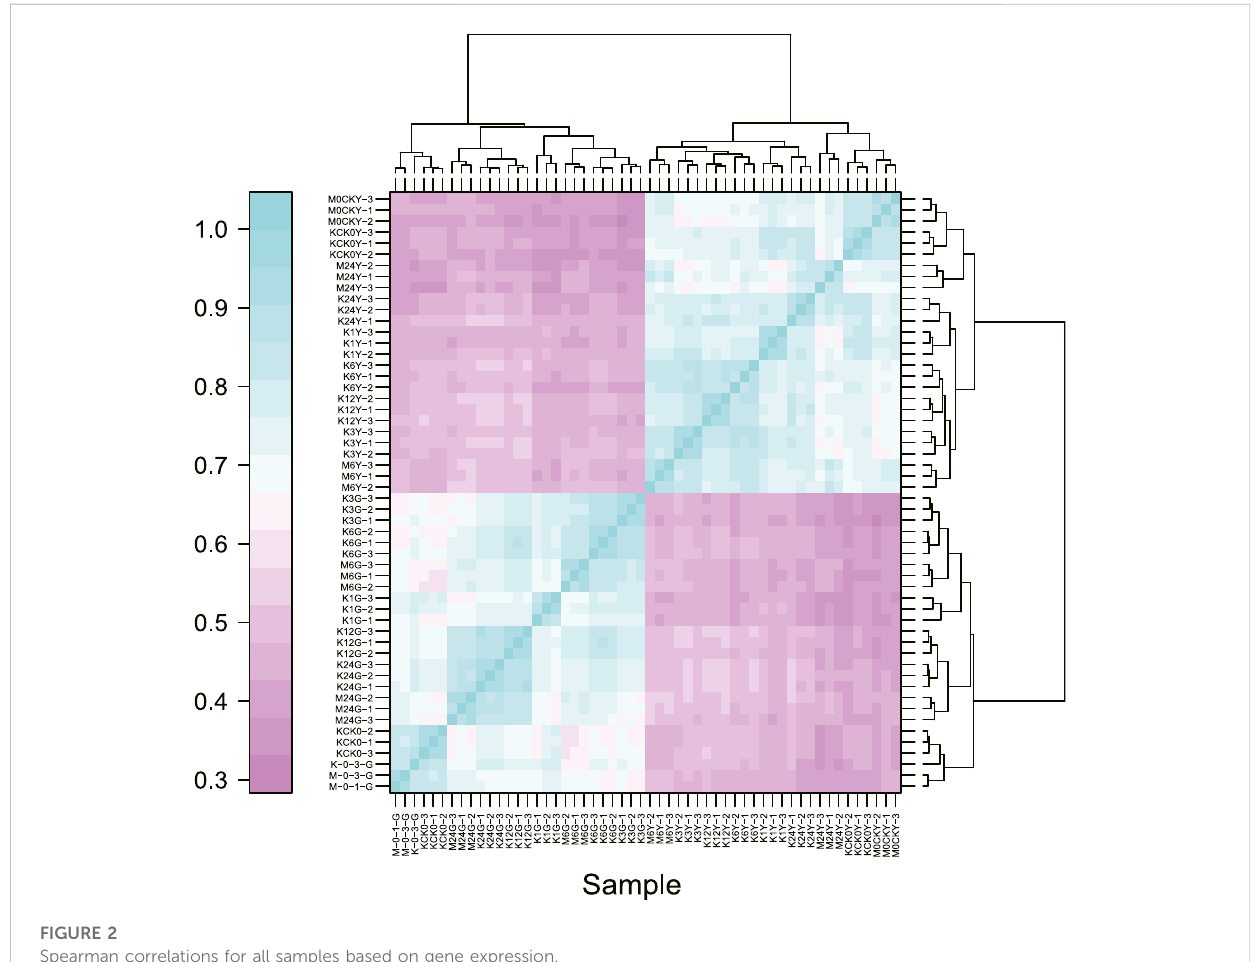
FIGURE 2 Spearman correlations for all samples based on gene expression.